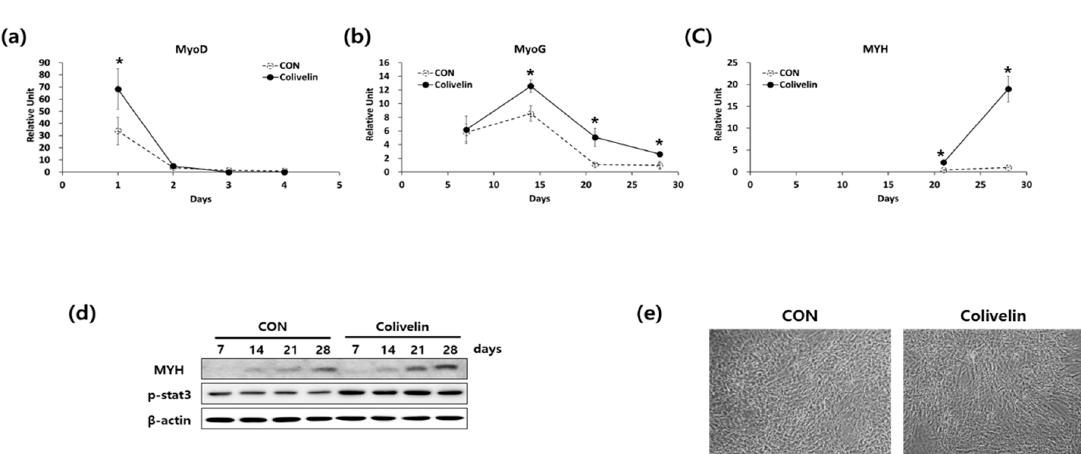
Figure 5. Effect of a colivelin on myogenic differentiation. ( a – c ) mRNA expression of ( a ) MyoD, ( b ) MyoG, and ( c ) MYH during myogenic differentiation. n = 3 independent experiments, each assay was performed in duplicate All values are expressed relative to the gene expression observed at 6 weeks using protocol C. * p < 0.05 vs. protocol C. ( d ) Cell morphology after 4 weeks of differentiation. ( e ) The expression of MYH and p-STAT3 was analyzed by western blotting.